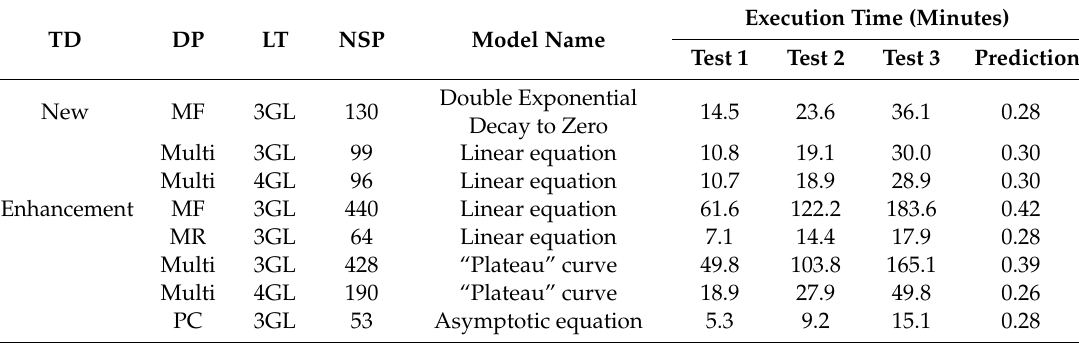
Table 11. Execution time of the experiments, using a sequential